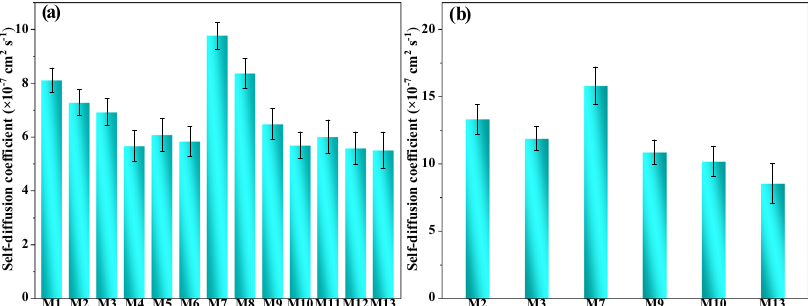
Fig. 7 Self-Diffusion Coef fi cient of the unaged and aged PDMS models. a main chain and b oxygen of hydroxyl group. The error bars stand for the standard deviations from fi ve independent sample. Note that there is no hydroxyl group in modes M1, M4, M5, M6, M8, M11, and M12.